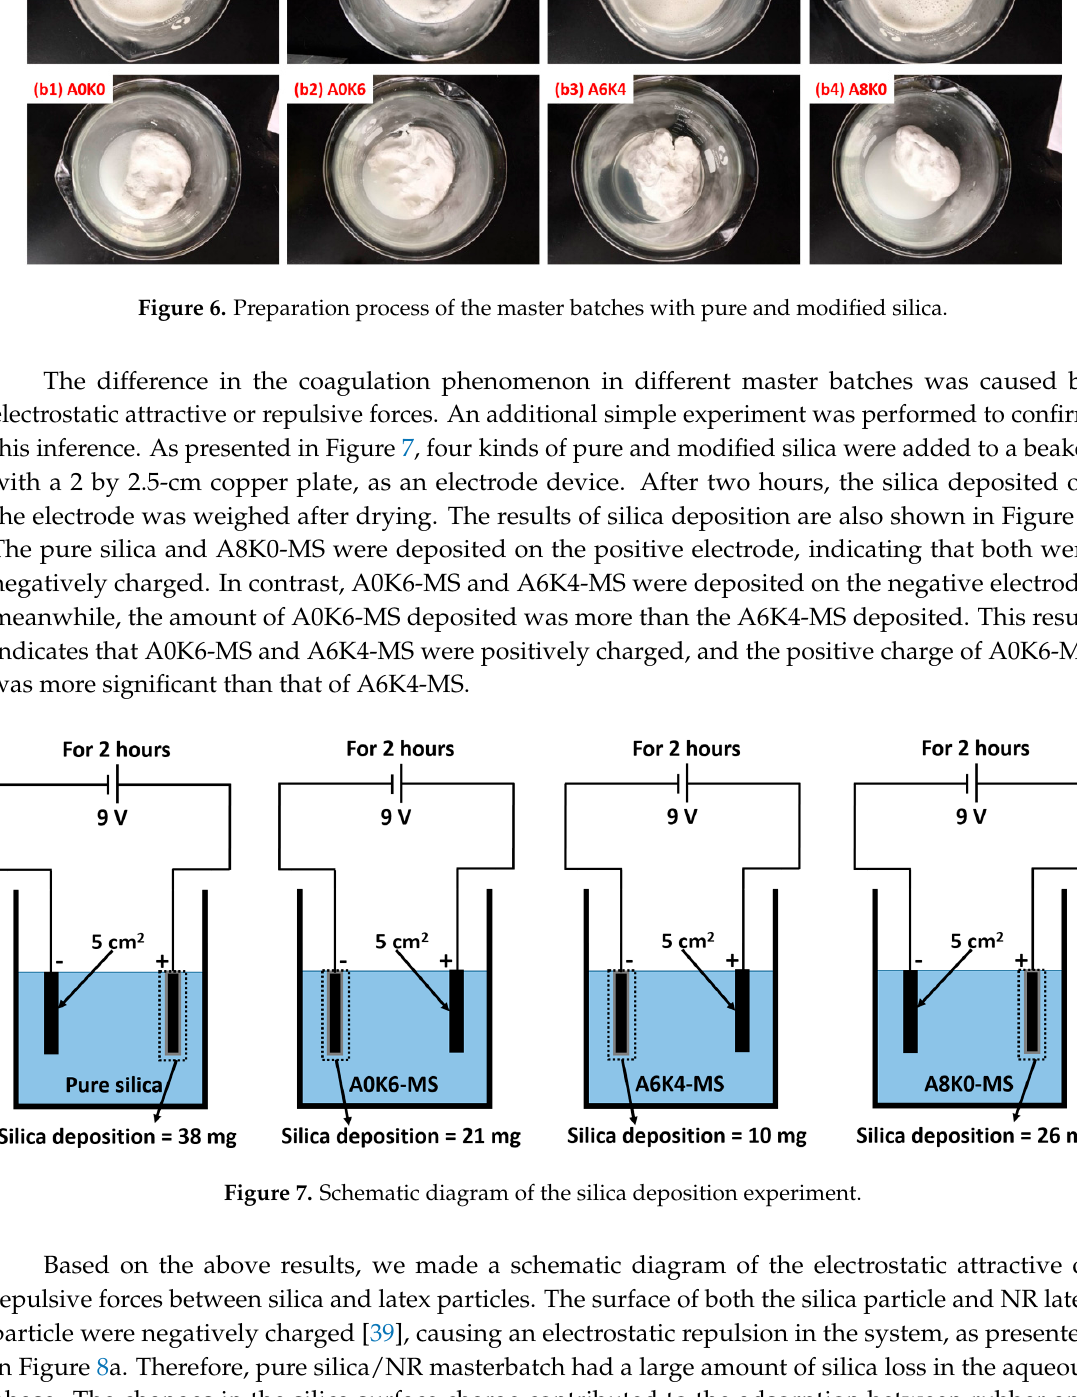
Figure 7. Schematic diagram of the silica deposition experiment.